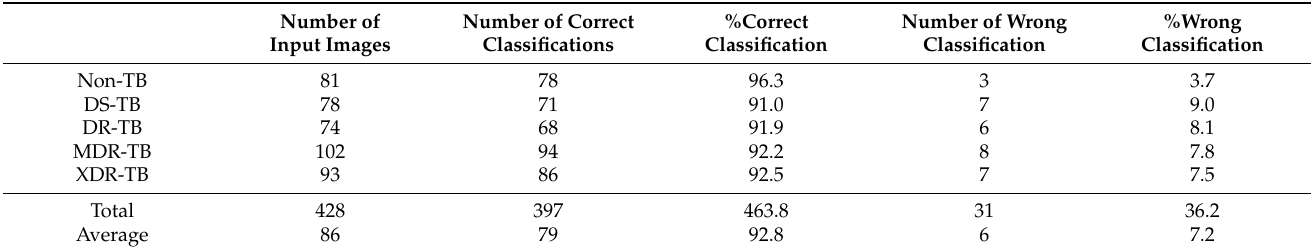
Table 8. TB-DRC-DSS accuracy